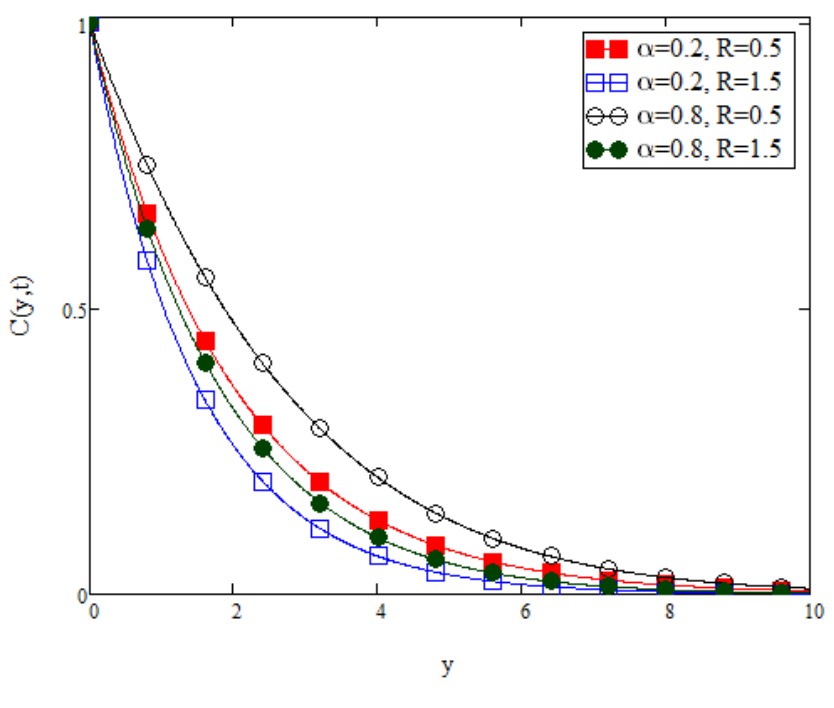
Figure 8. Variation in concentration profile due to variations in R and α .